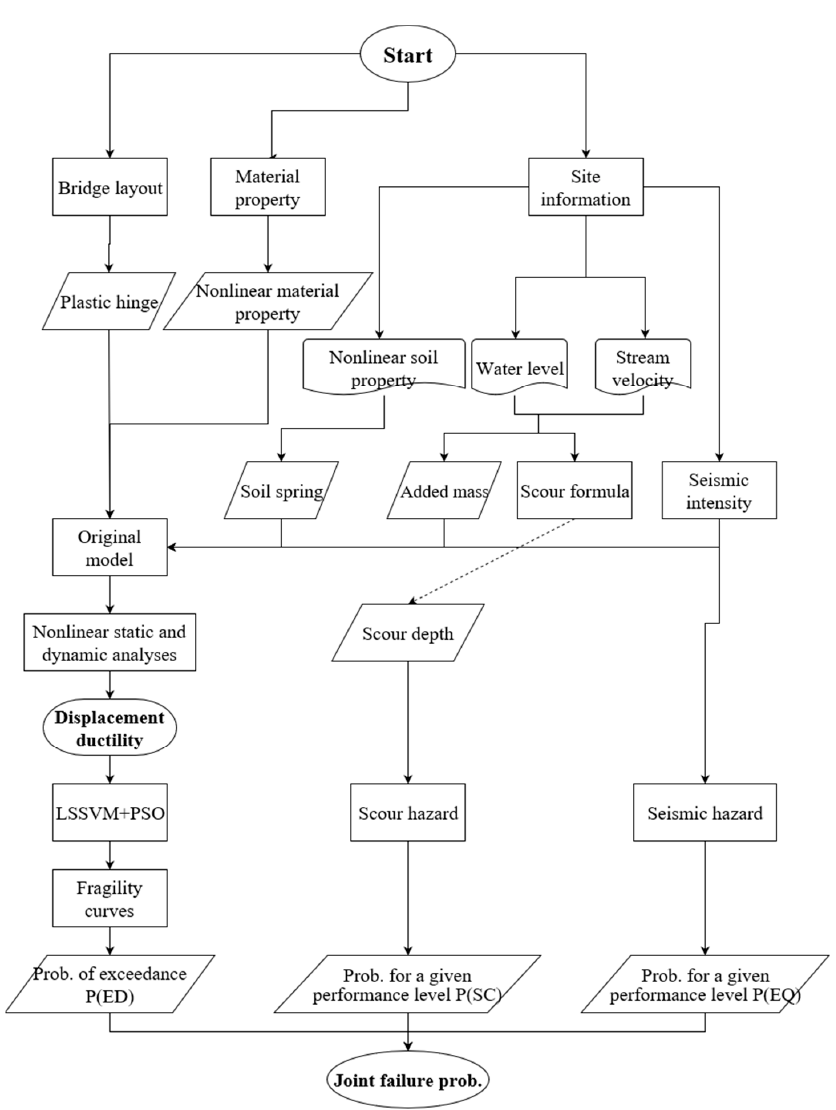
Figure 1. Flowchart of the proposed approach. (LSSVM: least-squares support-vector machine, PSO: particle swarm optimization, ED: exceedance, SC: scour depth, and EQ: earthquake).